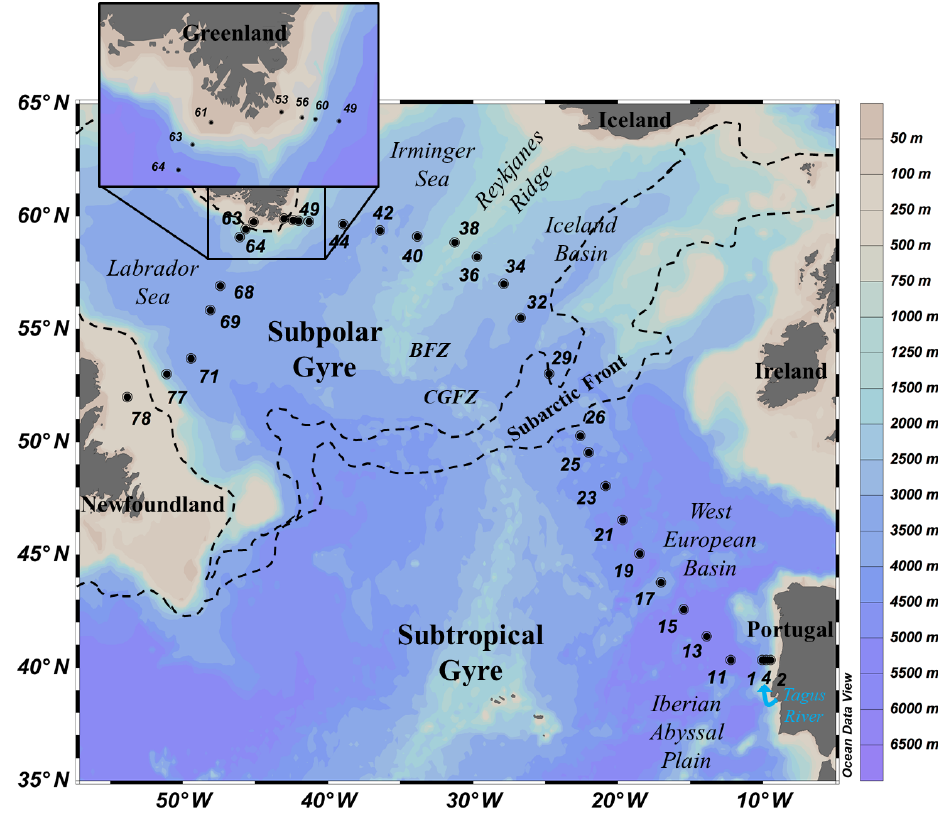
Figure 1. Map of the GEOTRACES GA01 voyage plotted on bathymetry as well as the major topographical features and main basins (Ocean Data View (ODV) software, version 4.7.6, Schlitzer, 2016; http://odv.awi.de, last access: 30 January 2020). BFZ: Bight Fracture Zone; CGFZ: Charlie-Gibbs Fracture